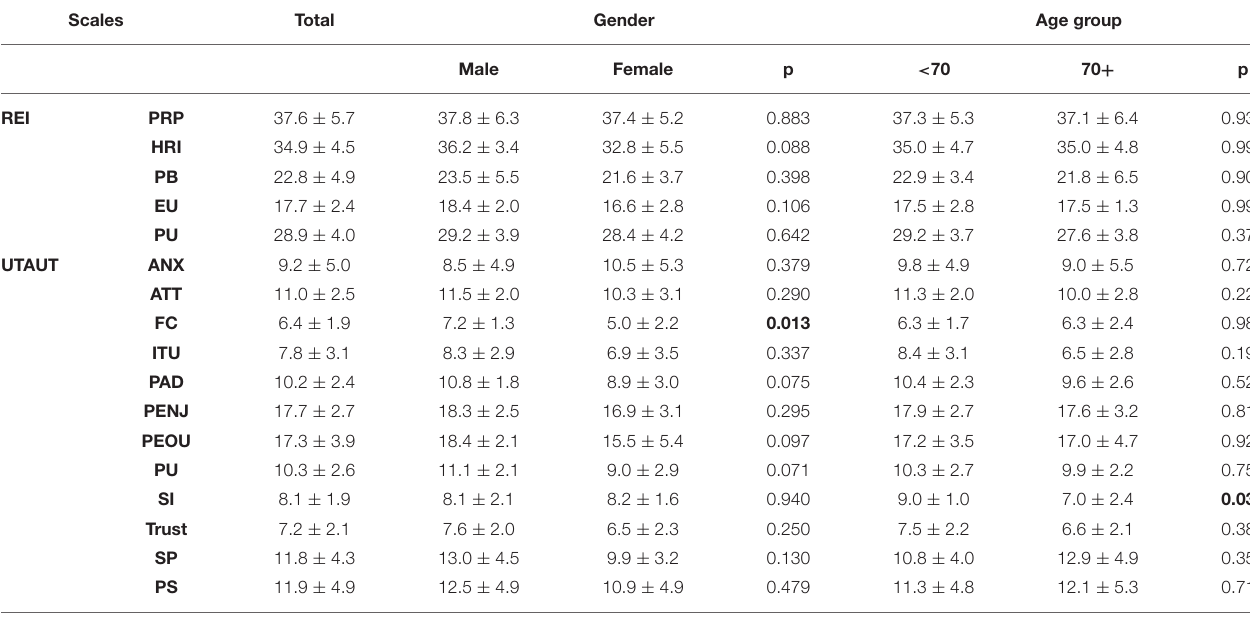
TABLE 6 | The Robot-Era Inventory scales and the UTAUT by the gender and age groups, mean ± SD. Scales Total Gender Age group Male Female